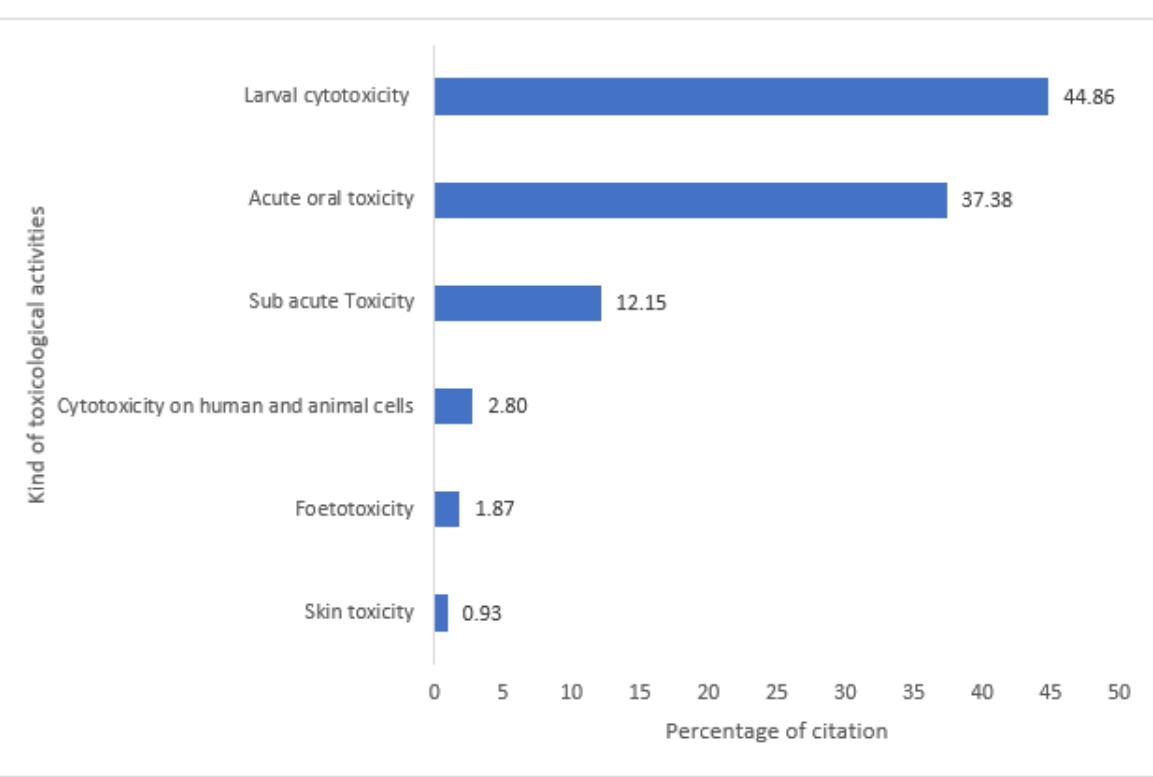
Figure 2. Summary of toxicology studies carried out on medicinal plants.